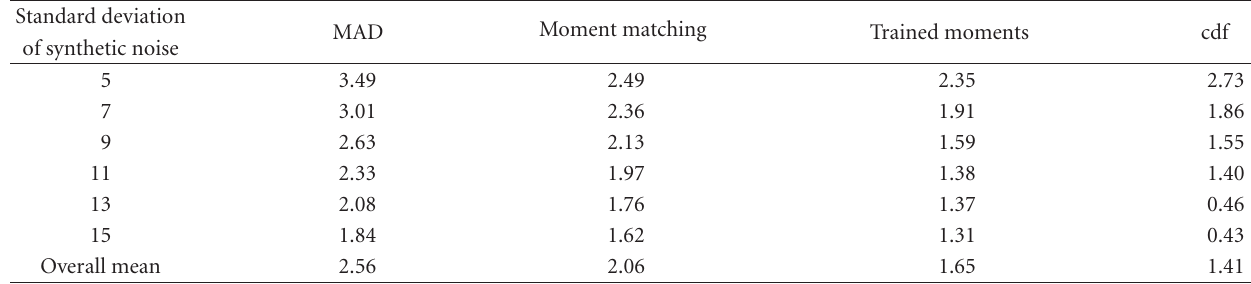
Table 1: Mean squared errors for noise standard deviation estimates computed over 5 images.